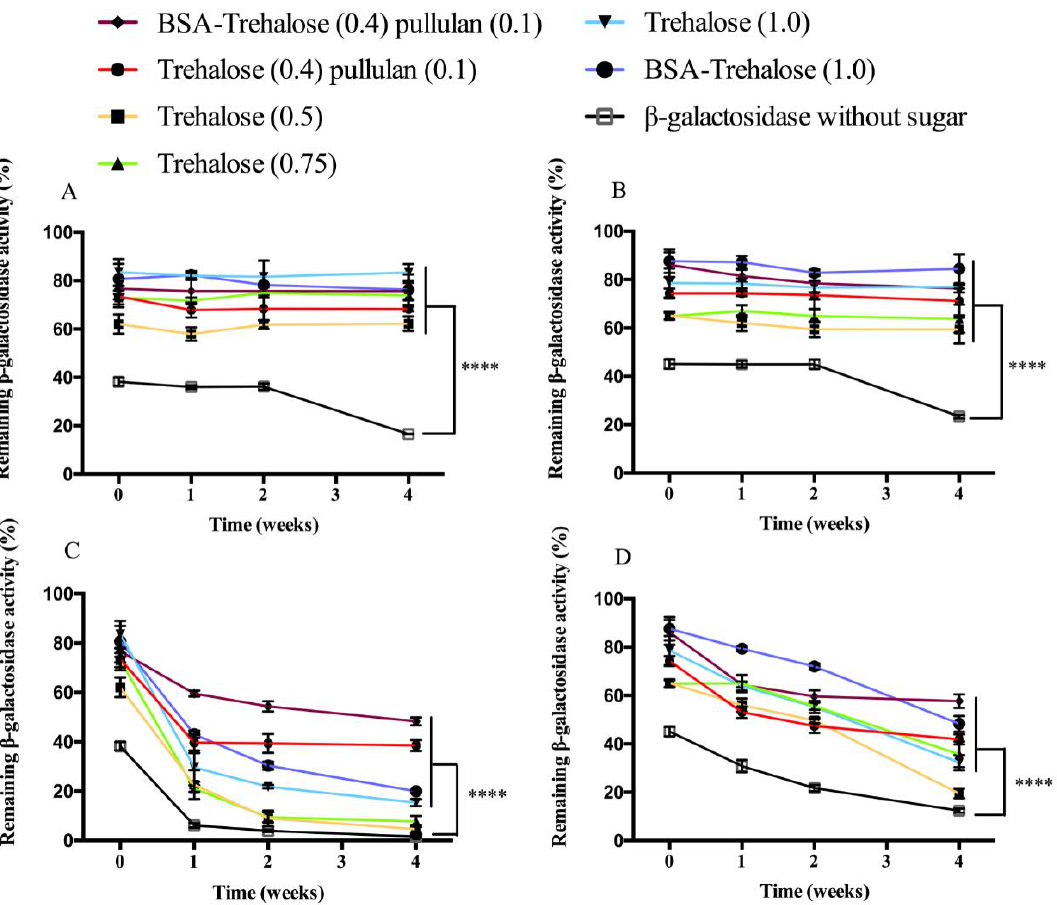
Figure 1. Process and storage stability of β -galactosidase incorporated in air- ( A and C ) and vacuum-dried ( B and D ) ODFs up to 4 weeks at 4 ◦ C / 0% RH ( A and B ) or 30 ◦ C / 0% RH ( C and D ). Levels of significance are denoted as **** p < 0.0001.